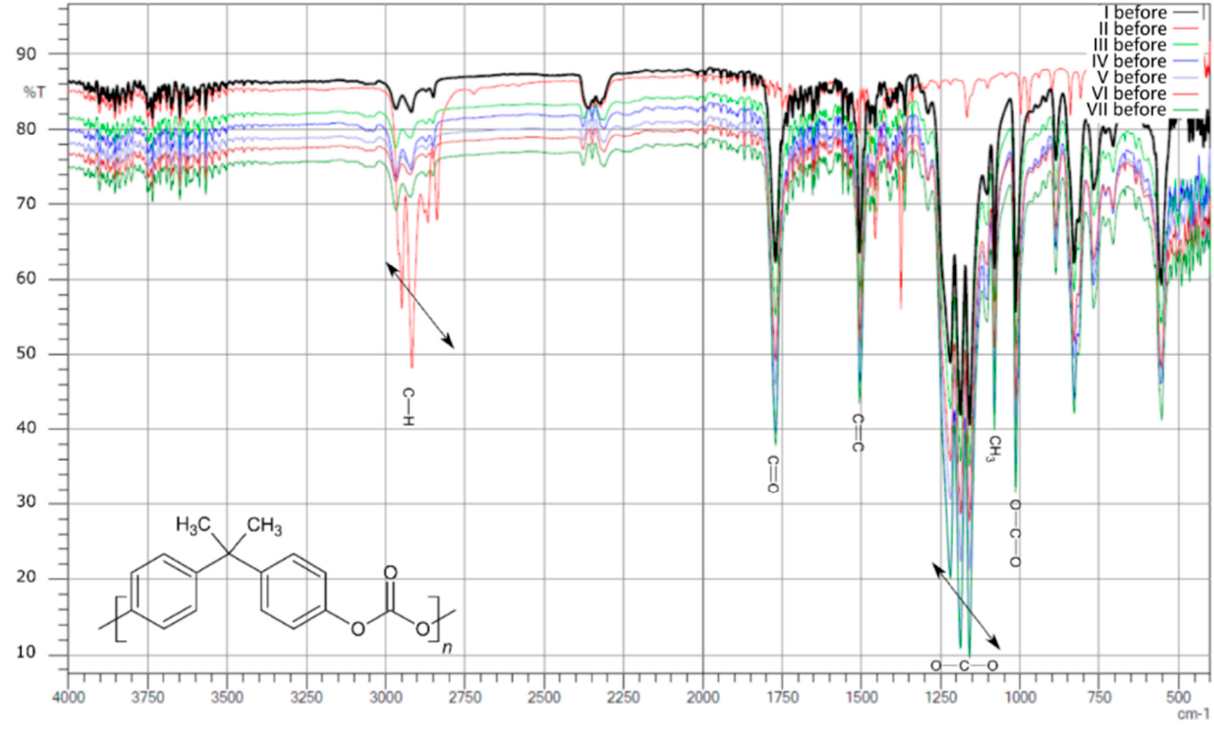
Figure 3. Compilation of IR spectra before aging for samples I, II, III, IV, V, VI, and VII .